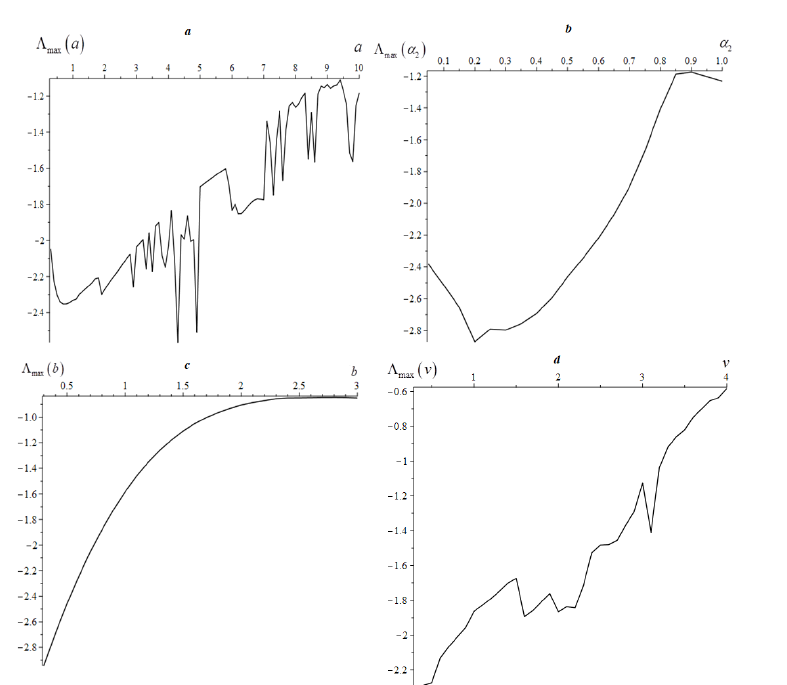
Figure 2. Spectra of maximum Lyapunov exponents: a – Λ max ( a ), b – Λ max ( α 2 ), c – Λ max ( b ), d – Λ max ( v